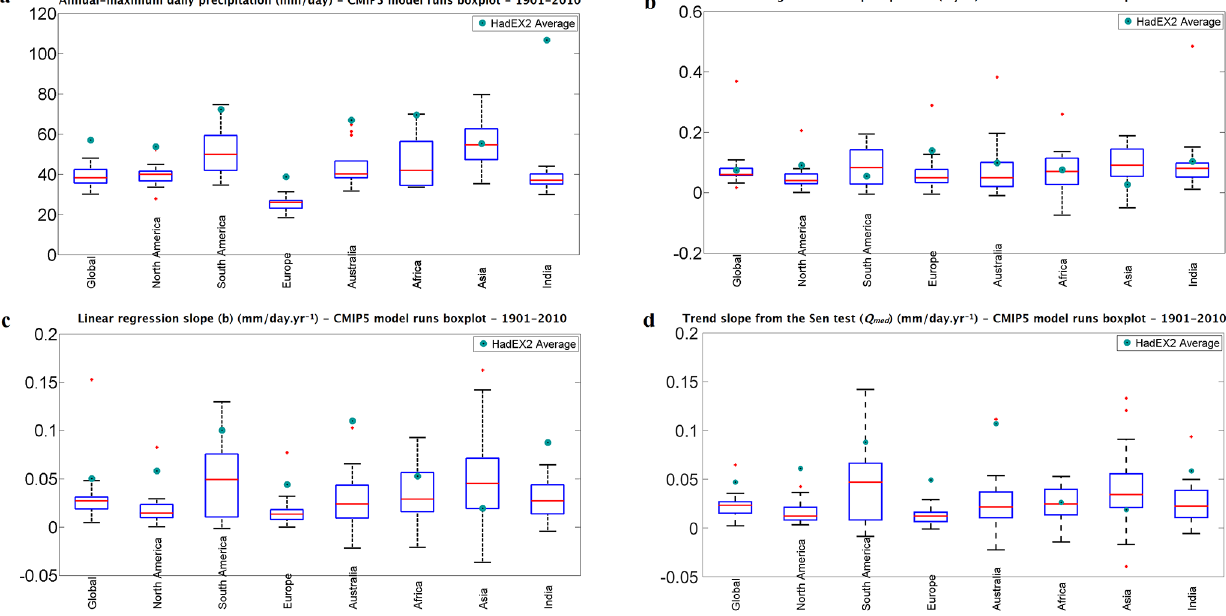
Figure 2. Boxplots of CMIP5 model run averaged results (minimum, 25th percentile, median, 75th percentile and maximum of the 19 model runs) as well as the average of HadEX2 observational data (shown as blue circles) for 1901–2010 extreme precipitation data on global and continental scales – (a) annual-maximum daily precipitation (mmday − 1 ), (b) relative change in annual-maximum daily precipitation (%yr − 1 ), (c) linear regression slope of change in annual-maximum extreme precipitation (mmday − 1 yr − 1 ), and (d) trend slope from the Sen test ( Q med ) (mmday − 1 yr − 1 ). The red markers outside the boxes represent model